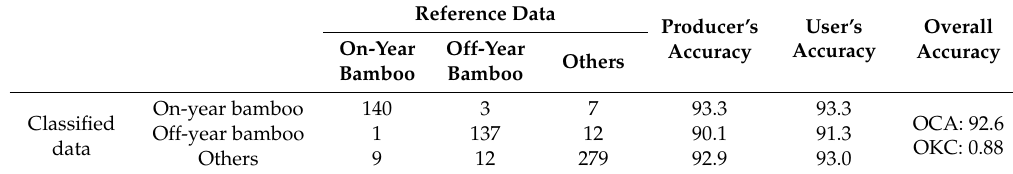
Figure 6. Spatial distribution of on-year and off-year bamboo forests for this study area. Table 5. Accuracy assessment results of on-year and off-year bamboo forests classification.